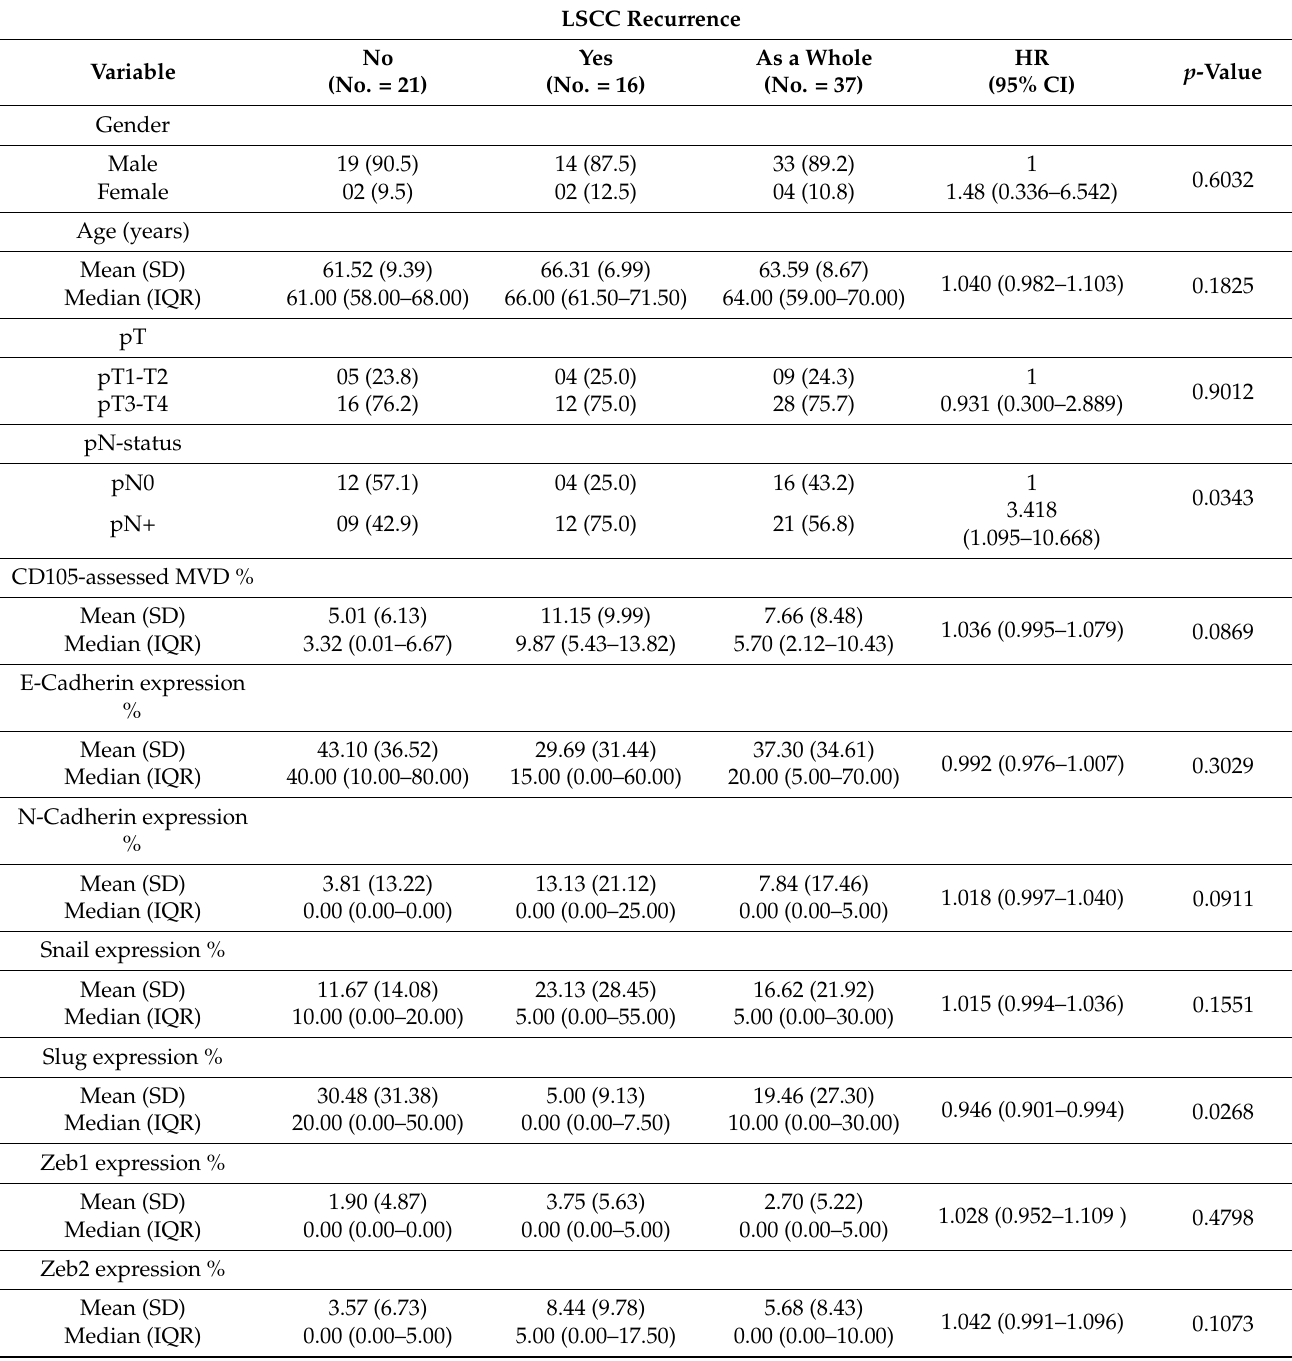
Table 1. Descriptive statistics of CD105-assessed MVD, EMT variables (E-cadherin, N-cadherin, Snail, Slug, Zeb1, and Zeb2 expressions), and conventional clinical-pathological features according to laryngeal squamous cell carcinoma (LSCC) recurrence, and univariate Cox regression analysis results for LSCC